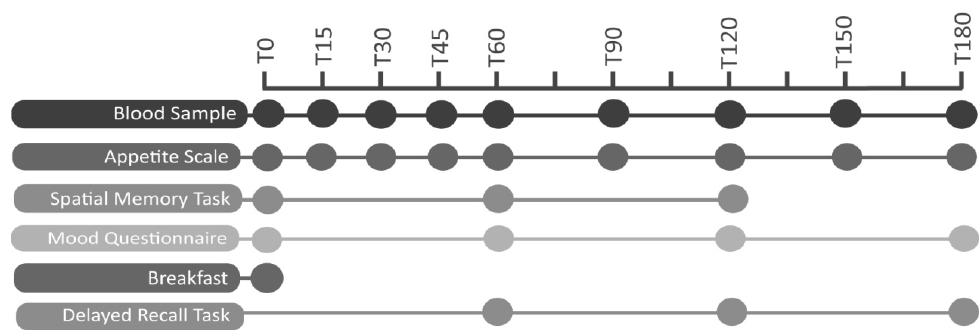
Figure 1. Testing day schedule (Study 2).